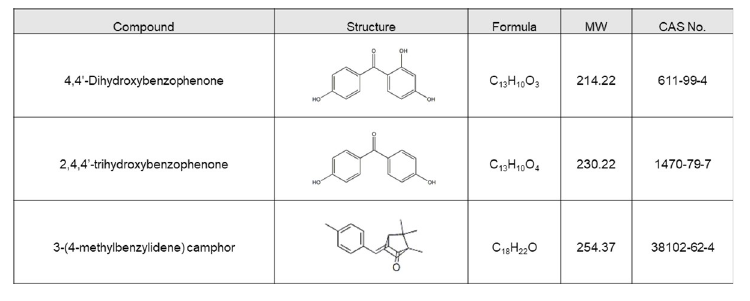
Fig 1. Structures of tested